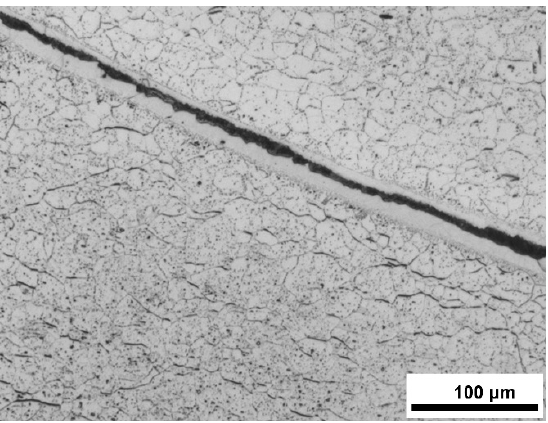
Figure 7. Band of pearlite formed during decomposition of an austenite film along the δ-ferrite grain boundary. The austenite decay began with the formation of epitaxial ferrite (precipitation-free band). LM.